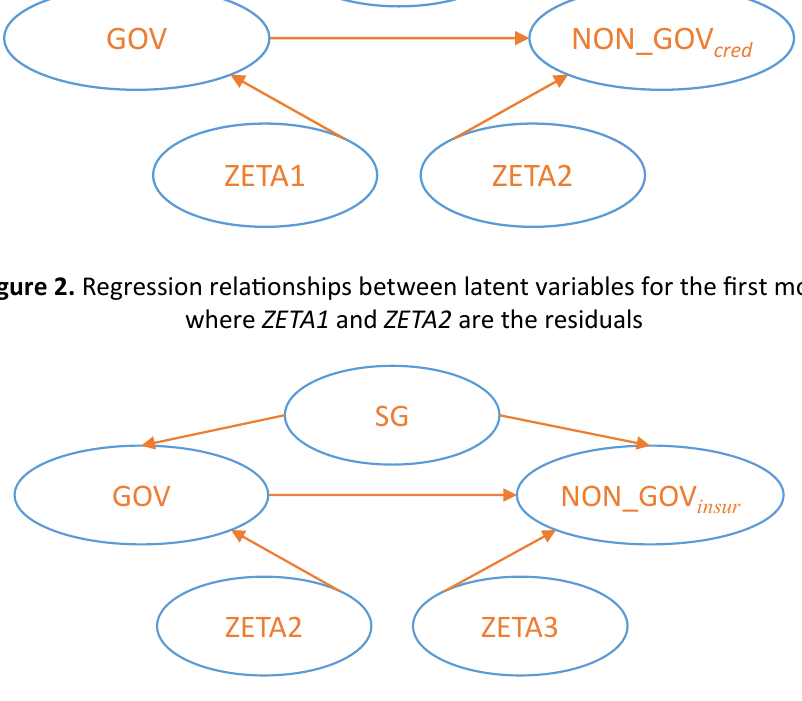
Figure 3. Regression relationships between latent variables for the second model, where ZETA2 and